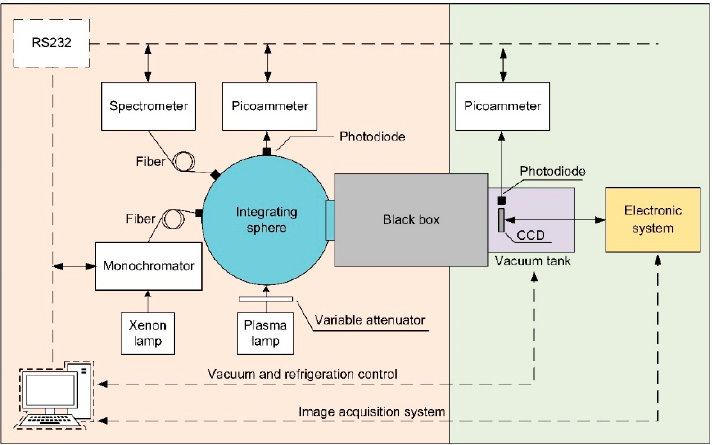
Figure 4. Structure diagram of the SVOM VT CCD test bench.